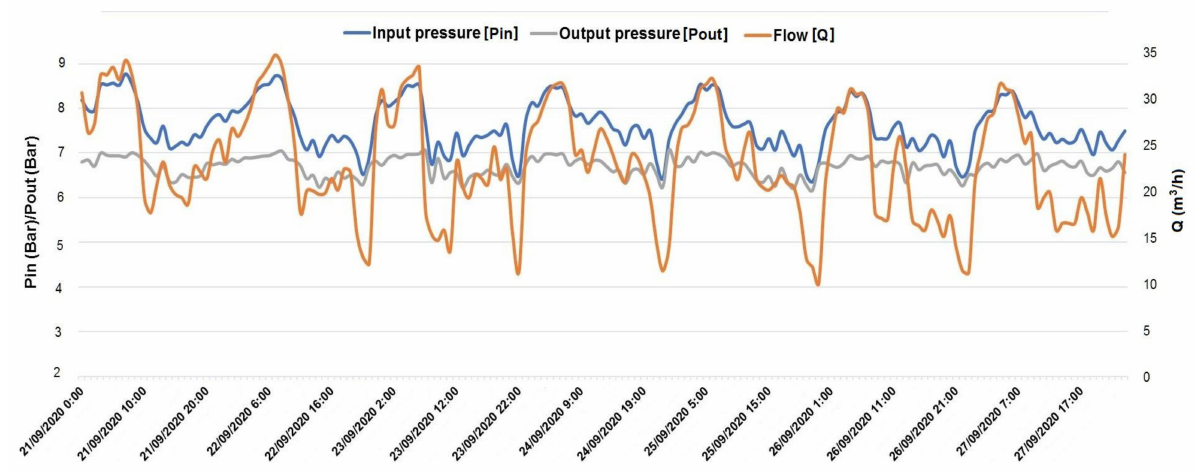
Figure 11. Water flows circulating in the ERT pipeline in the month of September.